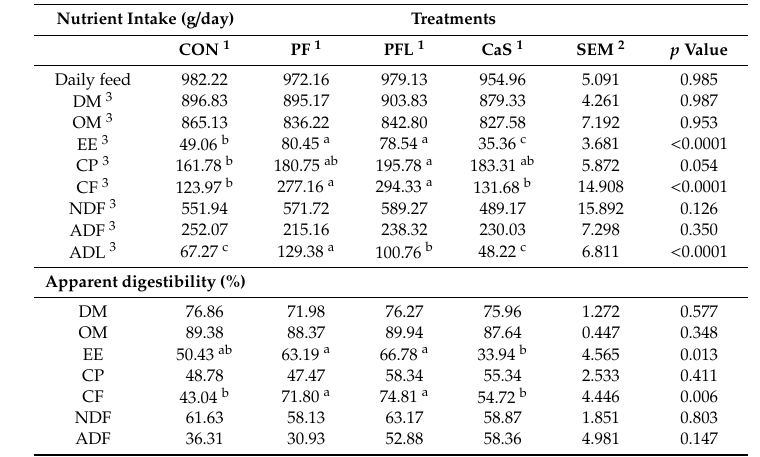
Table 5. E ff ect of di ff erent rumen protected fats on daily average nutrient intake and digestibility in Dorper sheep.